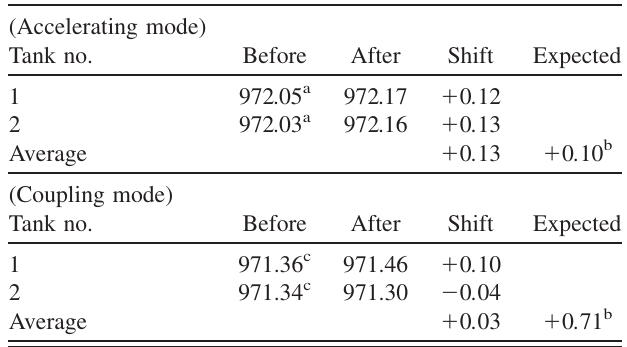
TABLE VII. Frequency shift due to the brazing process (unit: MHz). (Accelerating mode) Tank